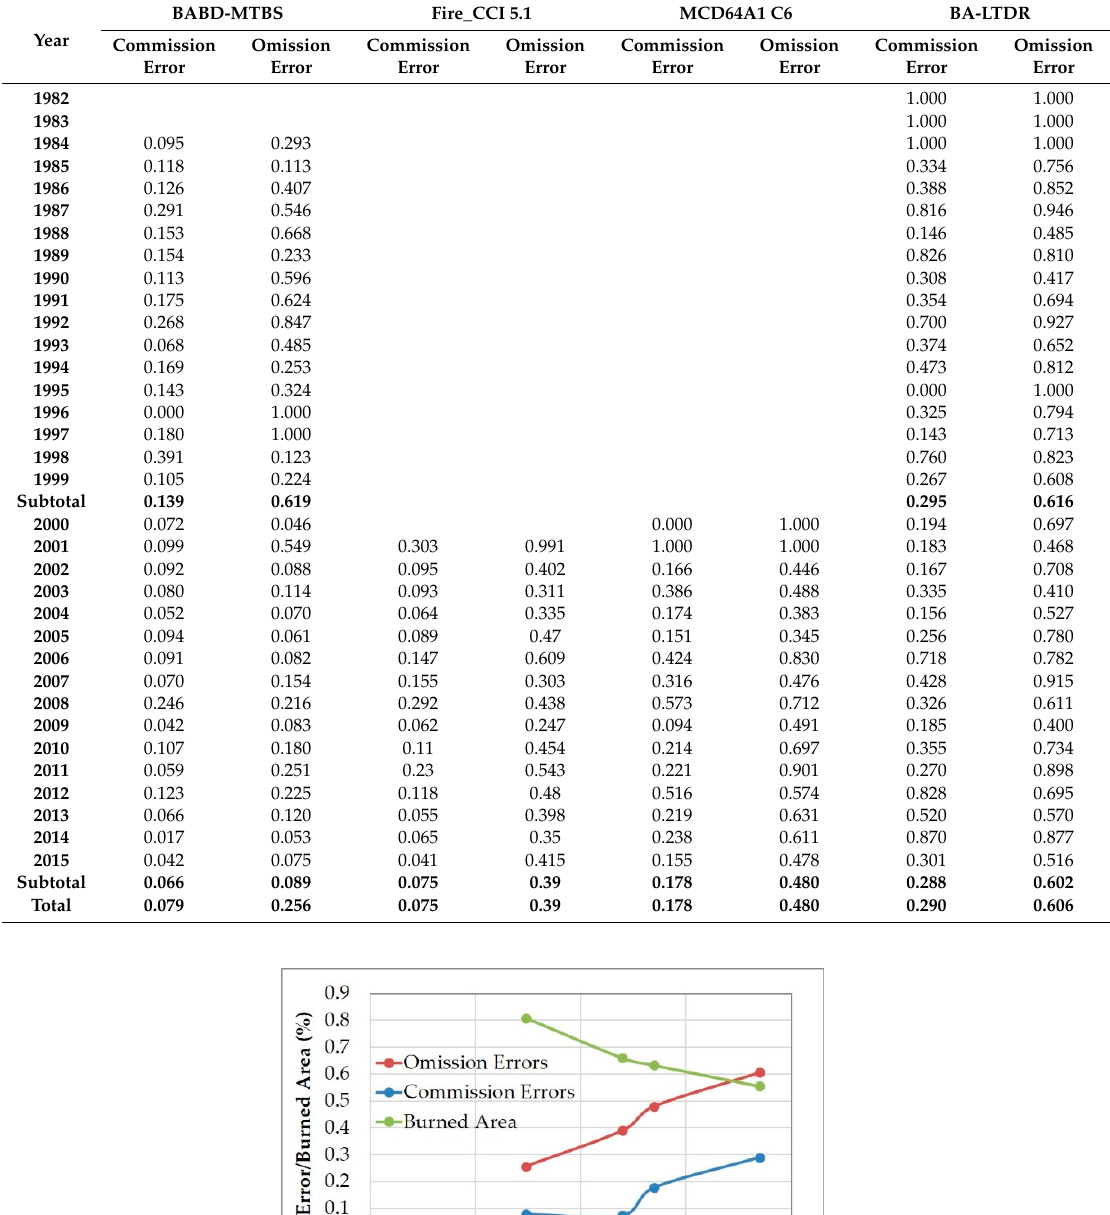
Table 3. Commission and omission errors by year for the Alaskan boreal region for the Burned Areas Boundaries Dataset-Monitoring Trends in Burn Severity (BABD-MTBS), Fire Climate Change Initiative (Fire_CCI) version 5.1, Moderate Resolution Imaging Spectroradiometer (MODIS) Direct Broadcast Monthly Burned Area Product Collection 6 (MCD64A1 C6), and burned area product from Long Term Data Record (BA-LTDR).